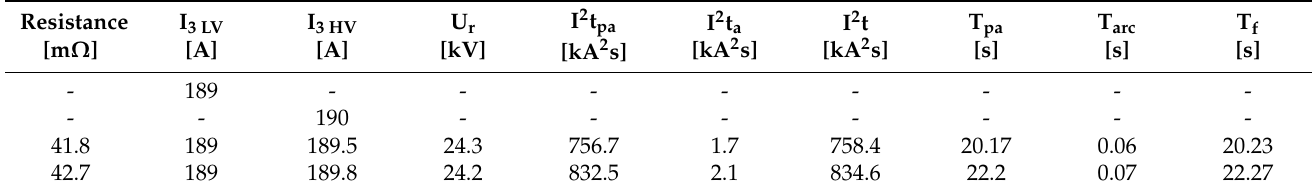
Table 9. Values obtained in I 3 series of